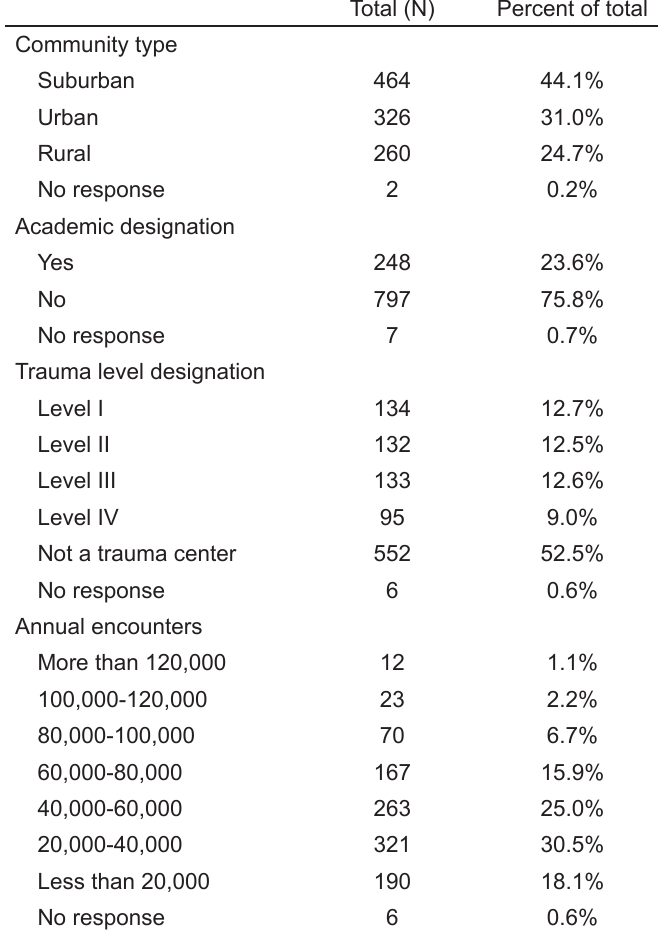
Table 2. Demographics of emergency departments included in